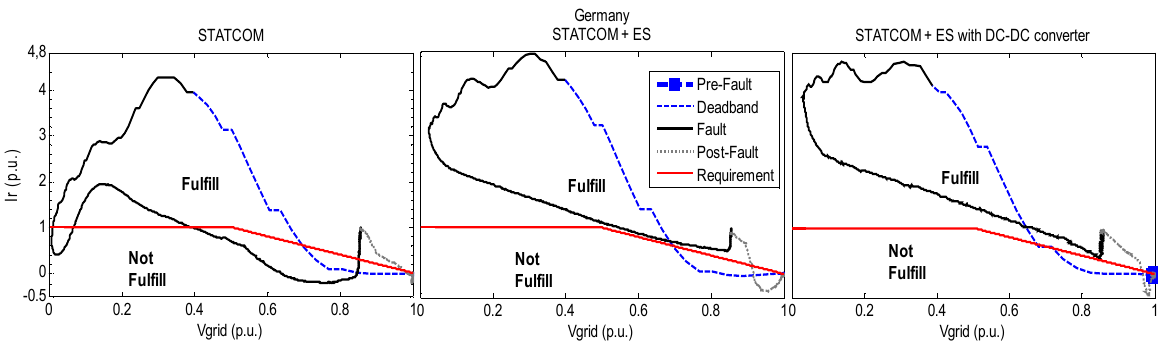
Figure 16. The solid black line corresponds to the reactive current behavior in the analysis zones, and the red one corresponds to the requirements. Note that the reactive current requirement is being fulfilled by means of the STATCOM + ES and STATCOM + ES with the DC-DC